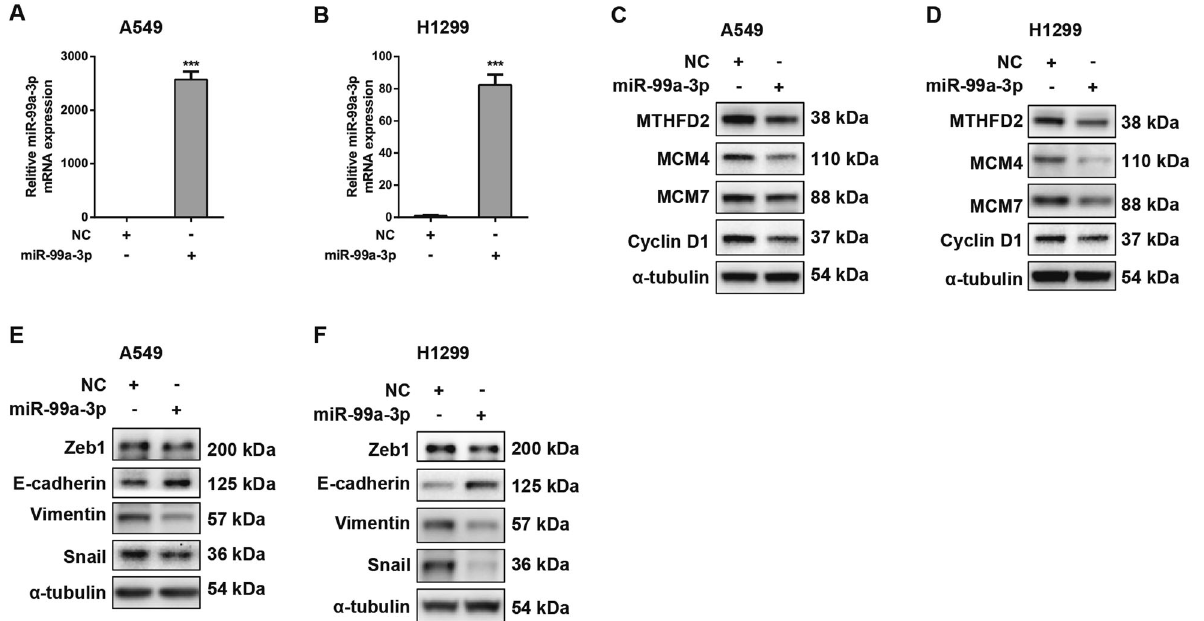
E , F The protein levels of Zeb1, E-cadherin, Vimentin and Snail in miR-99a-3p overexpressed A549 and H1299 cells. α -tubulin was used as an internal control. *** P < 0.001.